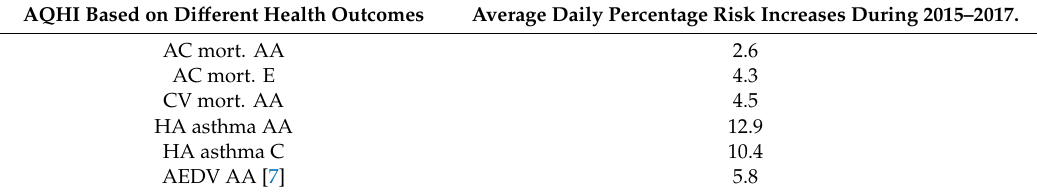
Table 5. The average daily percentage risk increases for di ff erent AQHIs based on di ff erent health outcomes during the period of